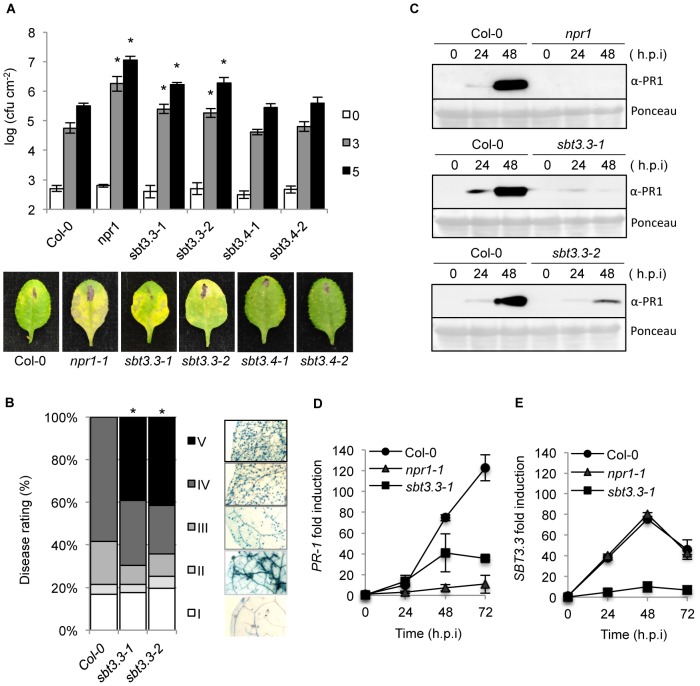
SBT3.3 loss of function increases disease susceptibility to P.
syringae DC3000 and H. arabidopsidis.(A) Five-week-old plants were inoculated with PsDC3000. Zero (white bars), three (grey bars) and five (black bars) days after inoculation, the bacterial growth was measured. Error bars represent standard deviation (n = 12). Asterisks indicate statistical differences to Col-0 (P<0.05) using Student's t test. Below are representatives of inoculated leaves of the indicated genotypes. (B) Quantification of H. arabidopsidis conidia development on Col-0, and sbt3.3-1 and sbt3.3-2 mutants. Asterisks indicate statistically different distributions of disease severity classes compared with Col-0 plants (χ2 test; α = 0.05). (C) Western blots with anti-PR1 antibodies reveals inhibition of PR1 induced accumulation in nrp1, sbt3.3-1 and sbt3.3-2 mutant plants, compared to Col-0, following inoculation with PsDC3000. The experiments were repeated three times with similar results. (D–E) Time-course RT-qPCR analysis showing PR-1 (D) and SBT3.3 (E) gene expression in Col-0, sbt3.3-1, and npr1-1 plants after infection with PsDC3000. Data represent the mean ± SD; n = 3 replicates and gene expression given as in Fig. 1.